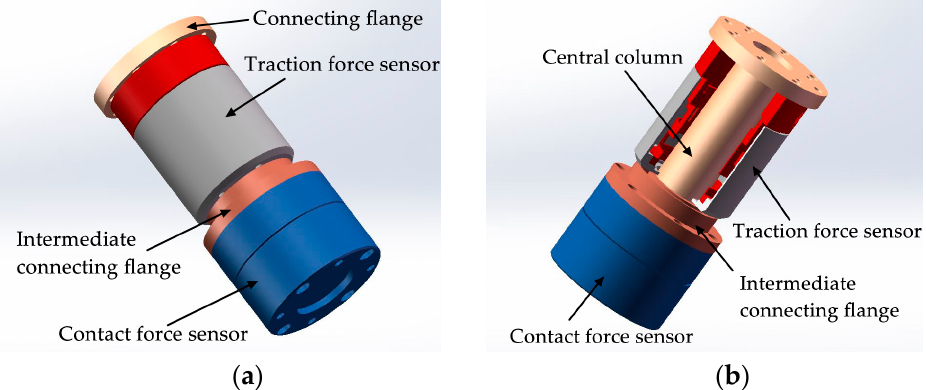
Figure 4. Schematic diagram of the developed tandem force sensor: ( a ) structure of the developed tandem force sensor; ( b ) the inner structure of the developed tandem force sensor.